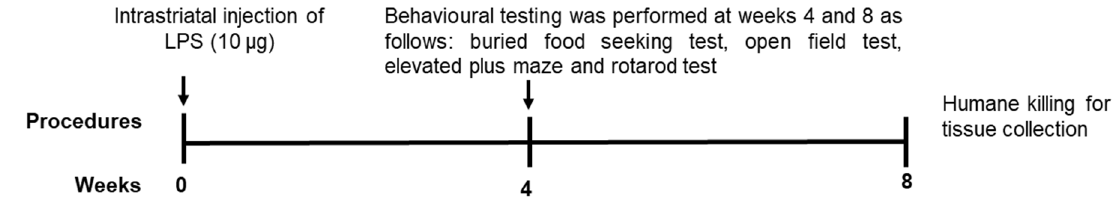
Figure 8. Timeline for intrastriatal administration of LPS in C57BL/6 mice. LPS was administered on day 1, followed by behavioural testing at 4 and 8 weeks post-treatment. The tissues were collected for subsequent analyses after the last behavioural test.